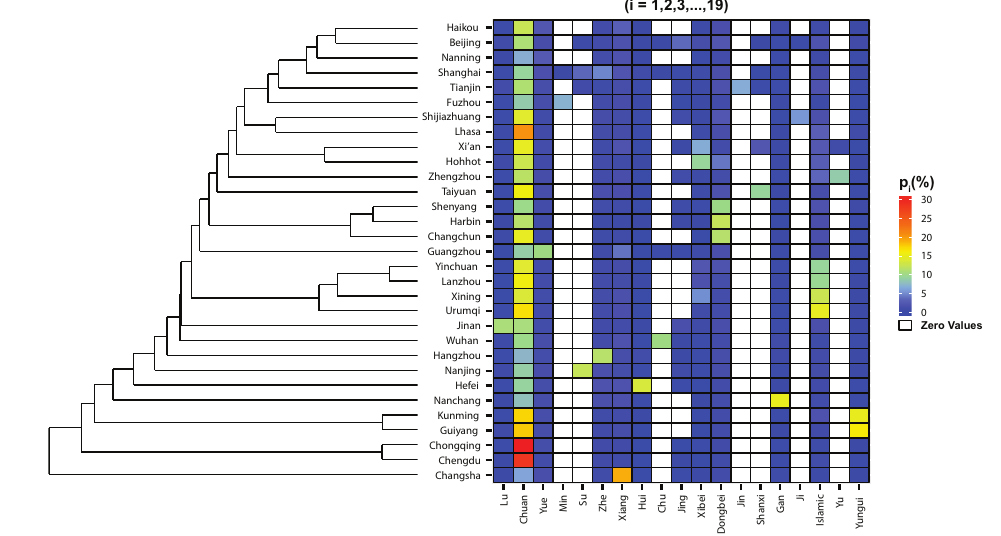
Figure 4. Percentage of restaurants in each individual city organized by regional Chinese cuisines (type 1 to type 19). The dendrogram illustrates the similarities between